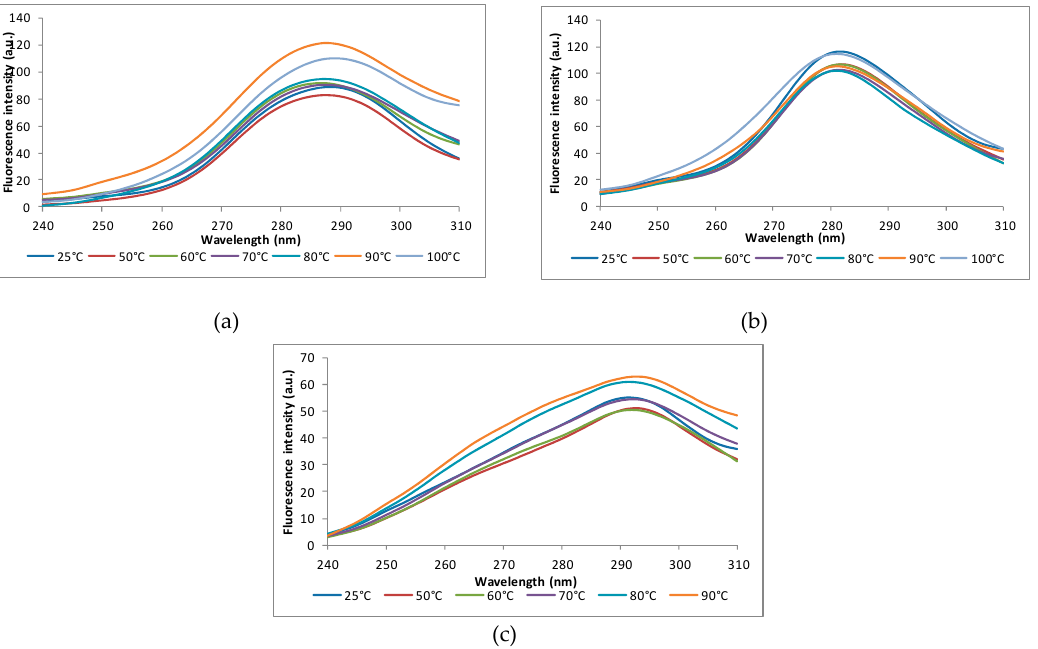
Figure 2. Synchronous fluorescence spectra of the rice proteins at Δλ = 15 nm at different temperatures values: ( a ) albumins, ( b ) globulins, and ( c ) glutenins. Three independent tests were carried out in each case and standard deviation (SD) was lower than 3.5%.